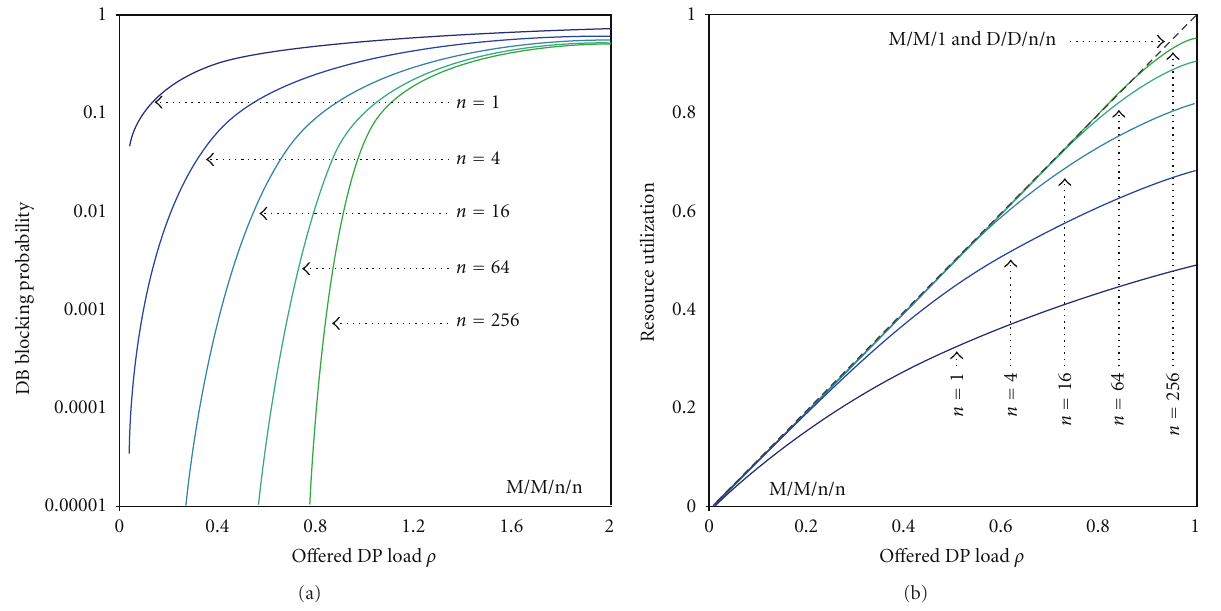
Figure 4: DB blocking probability (a) and achievable resource utilization (b) for di ff erent number of parallel channels over normalized data plane (DP) load ρ = λ/ ( nμ